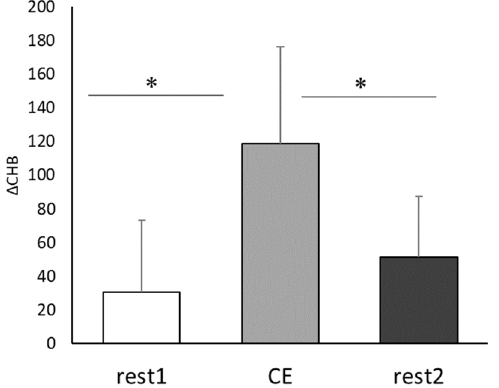
Figure 3. Comparison of changes in cerebral blood flow caused by Co-kara exercise. ∆ CHB: the mean value per minute of the change in total hemoglobin; CE: 15 min Co-kara exercise; rest 1:2 min rest before CE; rest 2:2 min rest after CE. ( n = 9) rest1 vs. CE, * p < 0.05 ( p = 0.012, r = 0.74), rest 2 vs. CE * p < 0.05 ( p = 0.03, r = 0.66).